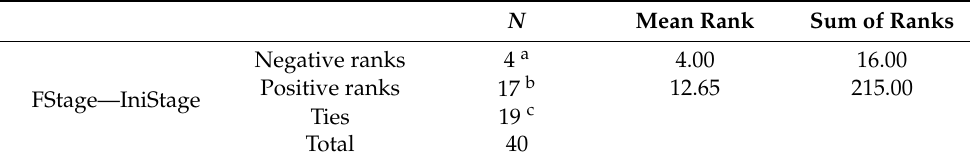
Table 7. Results of the ranks for the behavior change stages of the TTM scale. N Mean Rank Sum of Ranks Negative ranks 4 a 4.00 16.00 Positive ranks 17 b FStage—IniStage Ties 19 c Total 40